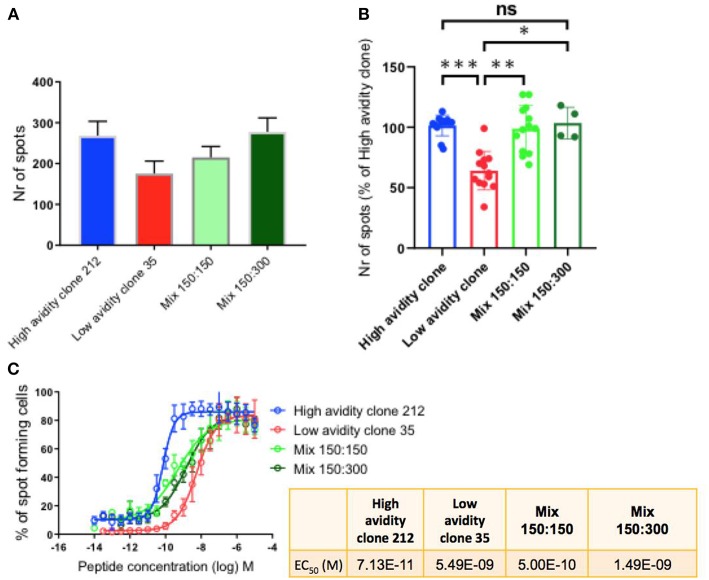
IFN-γ production by T cell clones, alone and in mixed cultures of high and low avidity clones. (A) The high avidity clone produced higher spot numbers in comparison to the low avidity clone. After mixing of the clones, plating half of the specific cells of the high avidity clone (150 cells), at ratios 1:1 and 1:2 with the low avidity clone, the absolute total spot numbers were still higher than the single condition of the low avidity clone. (B) Compiled data of three experiments showing statistically significant differences, One-way Anova, P-values ***<0.001; **<0.01; *<0.05. The T cell clones were analyzed by IFN-γ Elispot assays using T2 cells and 1 μM of Melan-A peptide. (C) IFN-γ Elispot assay with titrated peptide concentrations for determining the functional avidity of the clones, alone and as mixtures; the numeric values are shown in the small table.